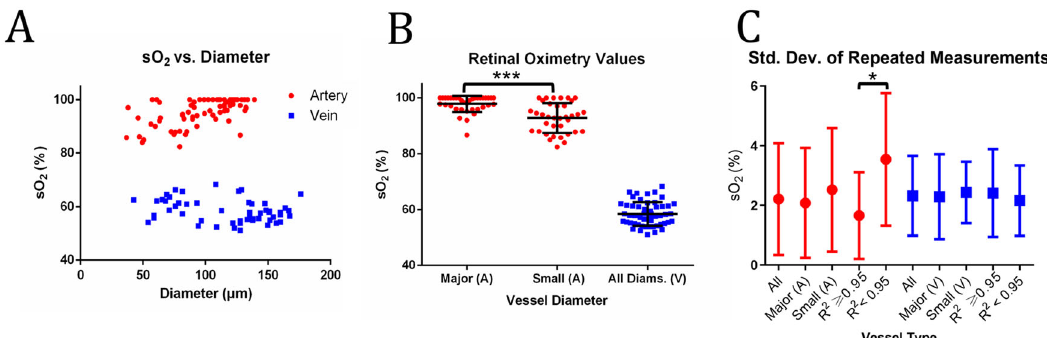
Fig. 5 Retinal sO 2 in a healthy cohort. A sO 2 measurements in 72 unique arteries (red) and 53 unique veins (blue) plotted against vessel diameter from 18 healthy volunteers; B Distribution of sO 2 measurements for major (diameter (cid:4) 100 μ m , n = 36) and small (diameter < 100 μ m , n = 36) artery calibers and all veins; C Repeatability of arteries and veins ( n = 24 for all artery, n = 17 for major artery, n = 7 for small artery, n = 17 for artery with R 2 ≥ 0.95, n = 7 for artery with R 2 < 0.95, n = 18 for all vein, n = 15 for major vein, n = 3 for small vein, n = 11 for vein with R 2 ≥ 0.95, n = 7 for vein with R 2 < 0.95). * indicates p <0.05 and *** indicates p <0.001 from two-sample t-test. All error bars are standard